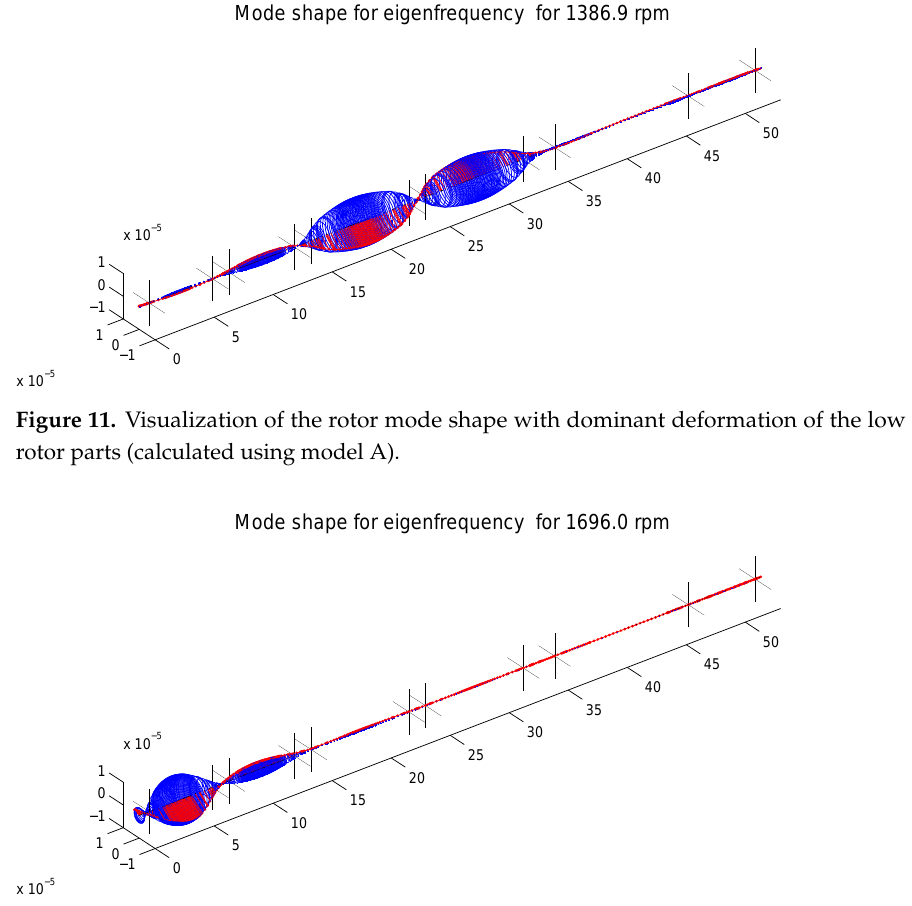
Figure 12. Visualization of the rotor mode shape with dominant deformation of the high and middle pressure parts (calculated using model A).